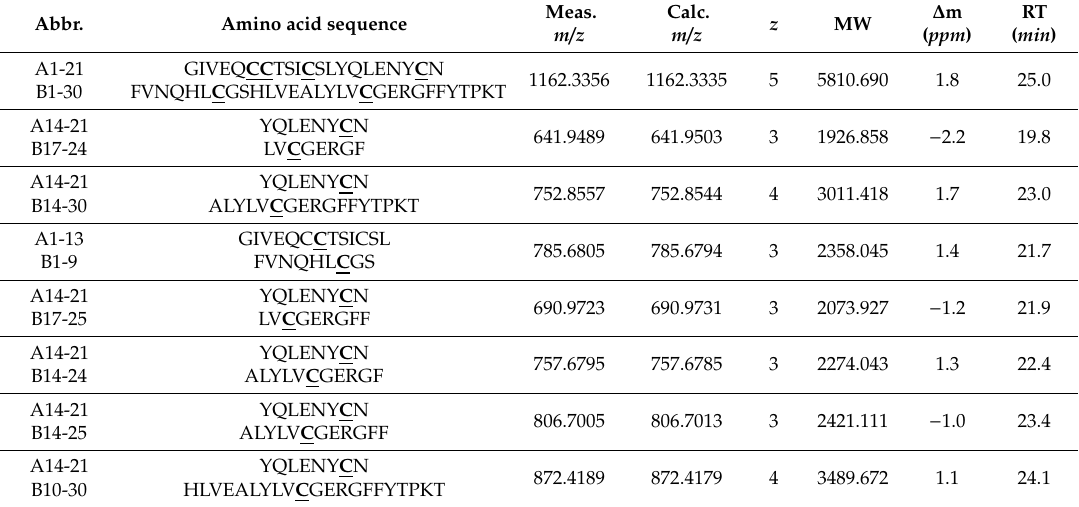
Table 2. List of all the identified IDE-promoted Ins hydrolytic peptides and their LC-MS features. The sulfur atoms involved in disulphide bonds are reported in bold and underlined ( Amino acid sequence column). “A” denotes insulin chain A and “B” denotes insulin chain